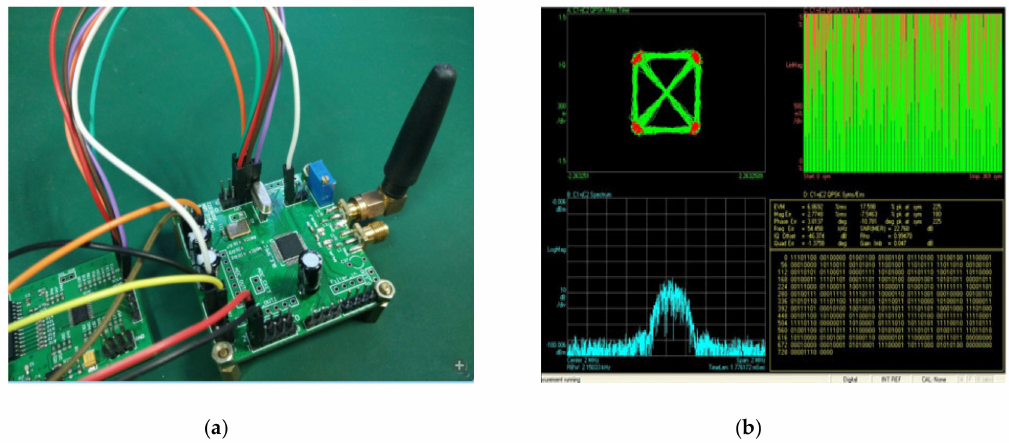
Figure 12. ( a ) The testing board of the proposed receiver. ( b ) The received signal at an IF frequency of 2 MHz with 250 kbps O-QPSK measured by Agilent 89600 VSA.